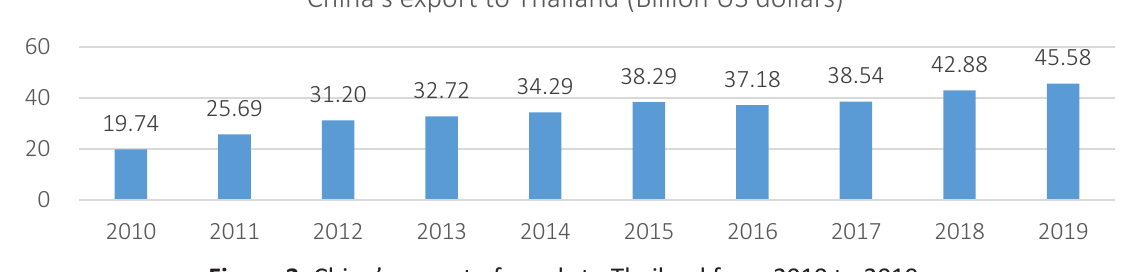
Figure 3. China’s export of goods to Thailand from 2010 to 2019